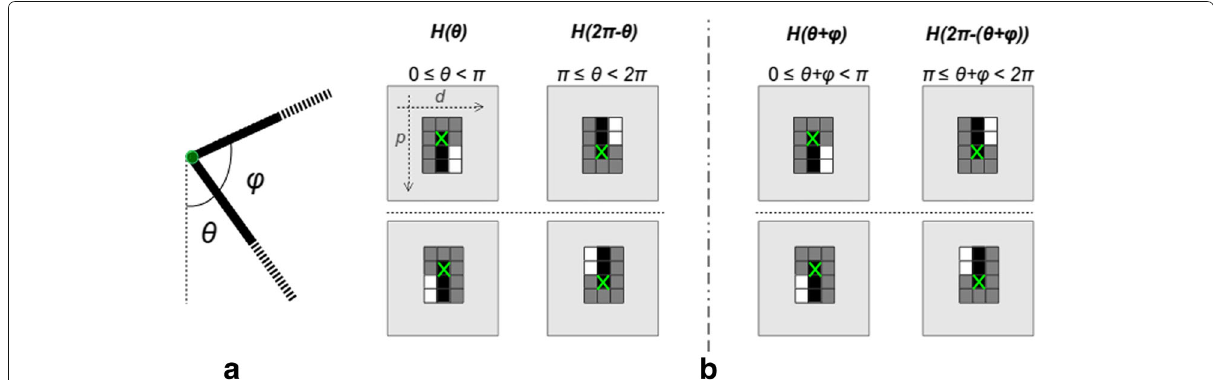
Fig. 6 Relation between an image corner and its representation in the 3D Hough space. a Image corner (corner position is represented by a green circle ). b Representation of an image corner in the 3D Hough space. Cells associated with the corner are marked with a green “x”